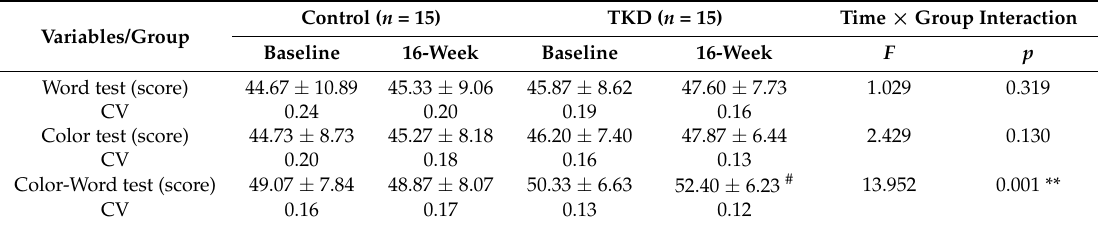
Table 6. Cognitive function parameters in the control and TKD groups before and after the intervention. Control ( n = 15) TKD ( n = Variables/Group